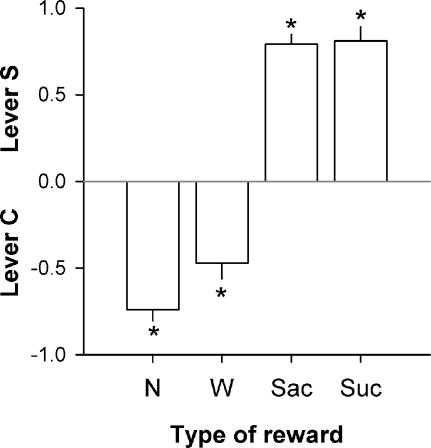
Choice between lever C and no fluid (N), water (W), saccharin (Sac, 0.2%) or sucrose (Suc, 4%).The horizontal gray line at 0 indicates the indifference level. Values above 0 indicate a preference for lever S while values below 0 indicate a preference for lever C. *, different from the indifference level (P<0.05, t-test). Each reward type (N, W, Sac and Suc) was tested at least 5 times in a row until stabilization of behavior. Bars represent the means (±SEM) of the last 3 stable days. The first 3 reward conditions (N, W and Sac in this order) were tested in the same group of animals (N = 10) while the sucrose condition was tested in a separate group (N = 10).